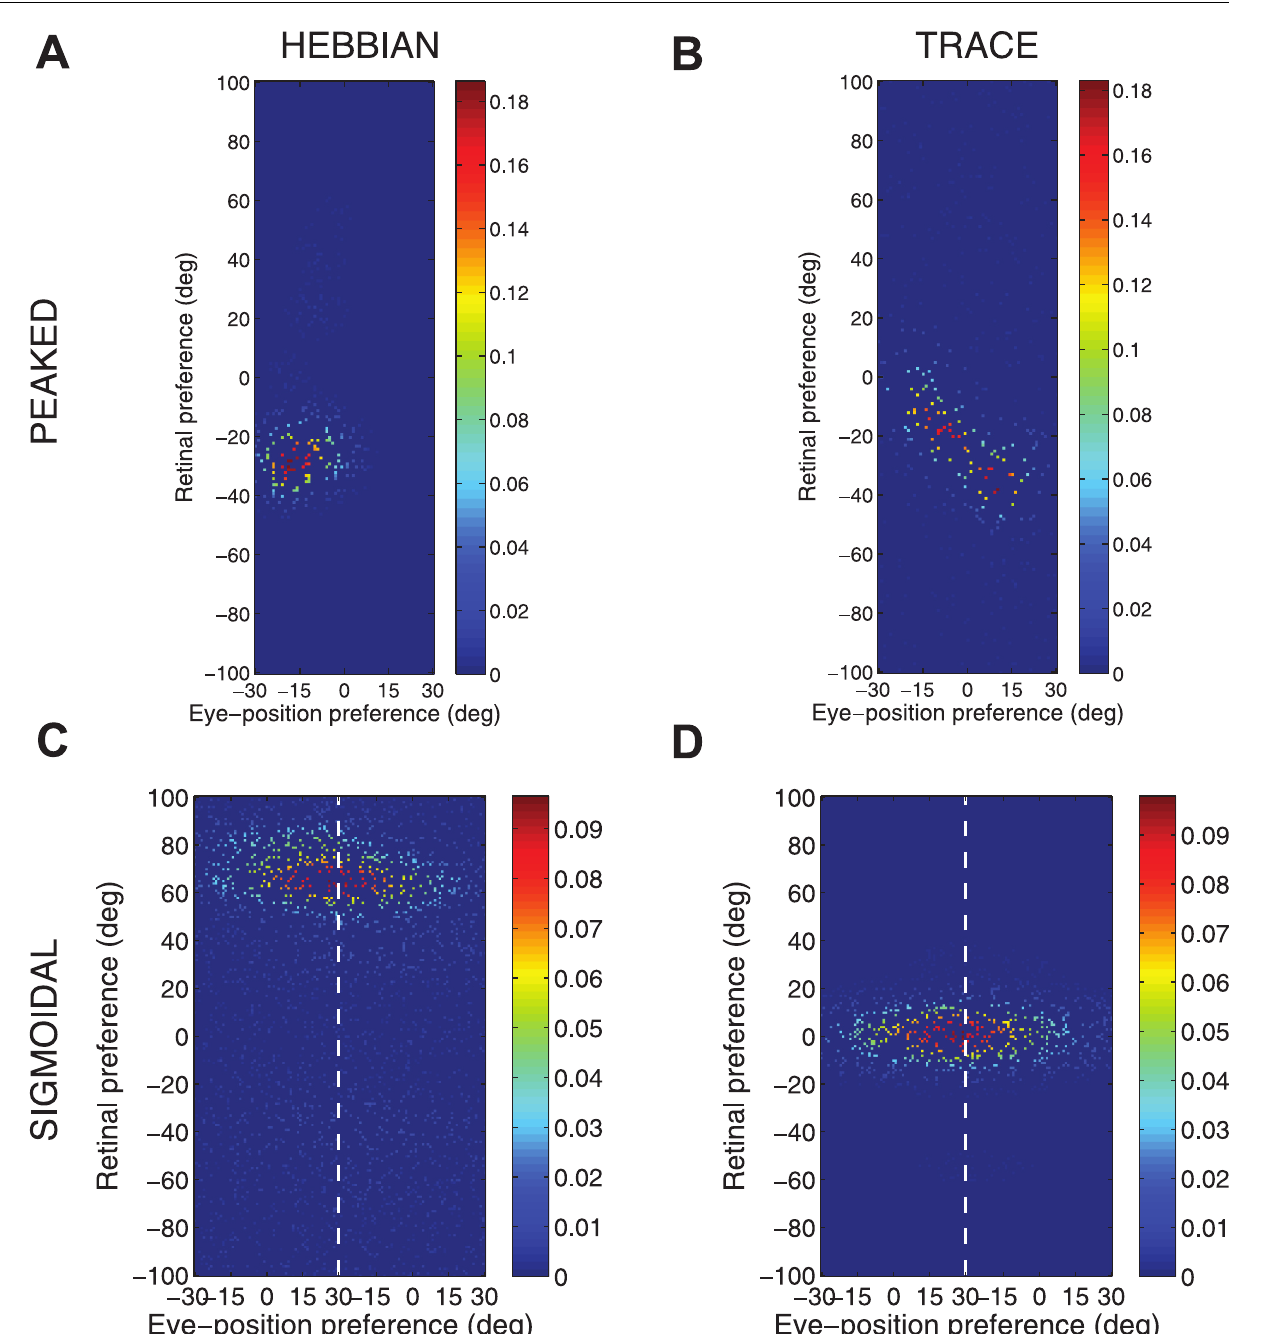
Fig 7. Weight vectors of two typical output neurons. The top row shows the weight vectors of two typical output neurons that develop when the input neurons have peaked eye-position gain modulation and the network is trained with either the Hebbian learning rule (A) or the trace learning rule (B) . The bottom row shows the weight vectors of two typical output neurons when the input neurons have monotonic eye-position gain and the network is trained with either the Hebbian learning rule (C) or the standard trace learning rule (D)